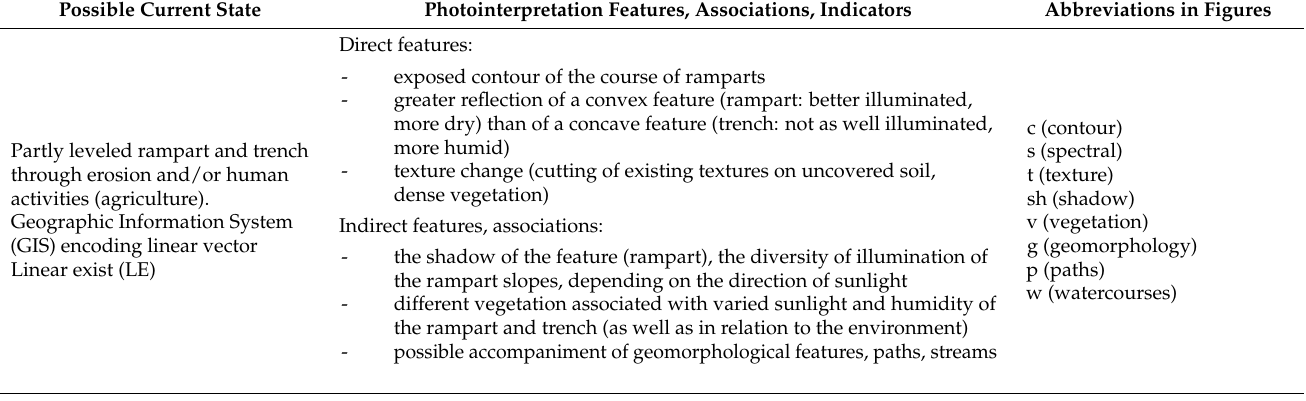
Table 2. Sought-after linear elements and related photointerpretation features anticipated in the satellite imagery. Possible Current State Photointerpretation Features, Associations, Indicators